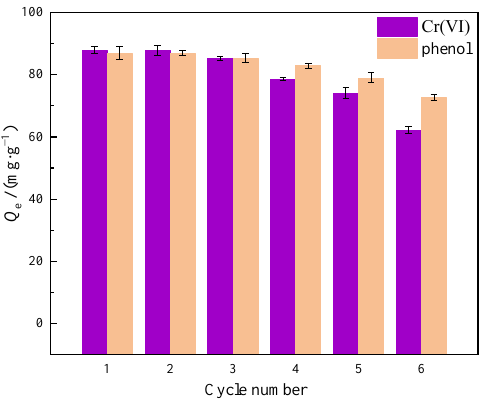
Figure 9. Adsorption – desorption cycle of Cr( Ⅵ ) on S1 and phenol on S2